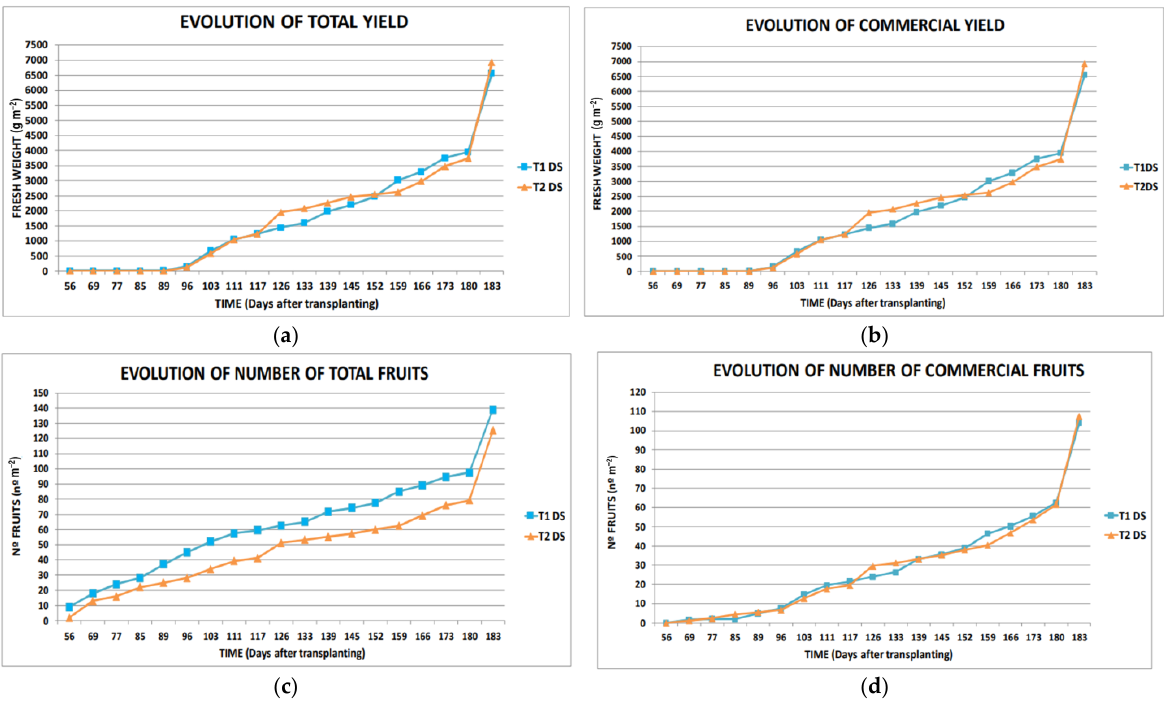
Figure 7. Yield of tomato crops grown in soil above PVC trays: ( a , b ) evolution of fresh weight accumulated of total and commercial fruits; ( c , d ) evolution of the total and commercial accumulated number of fruits.